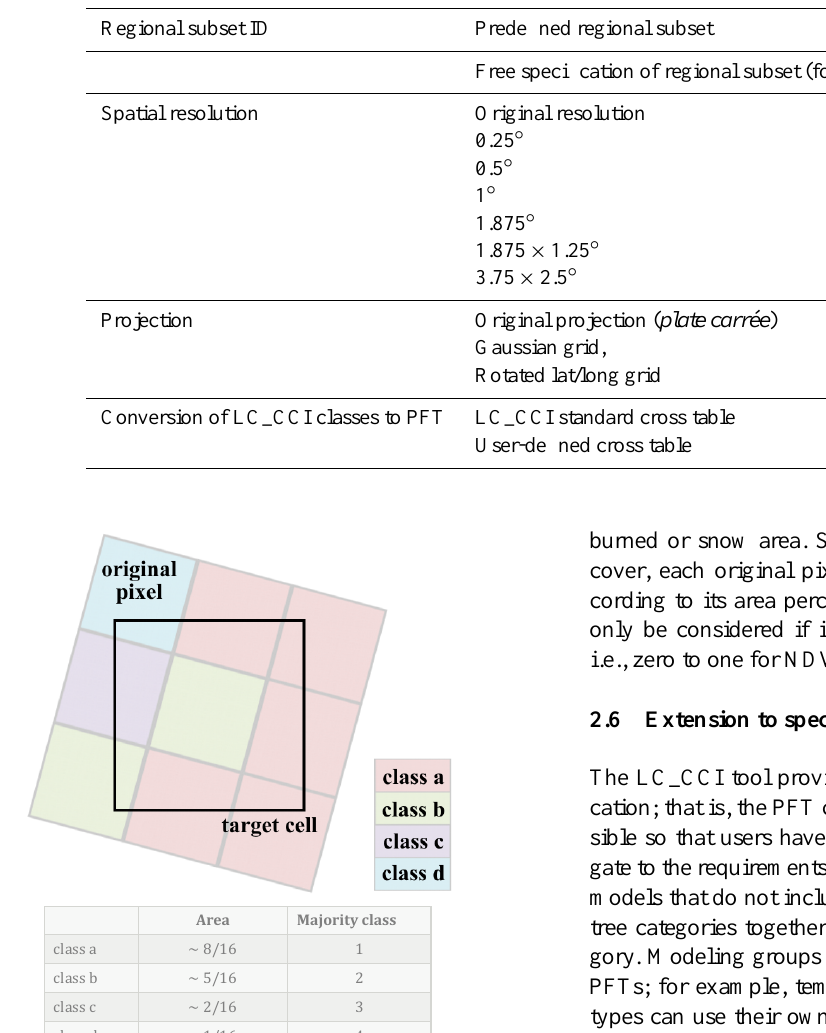
Table 3. Minimum set of projections and spatial resolutions included in the re-projection, aggregation, subset and conversion tool developed by the LC_CCI project – LC_CCI user tool.